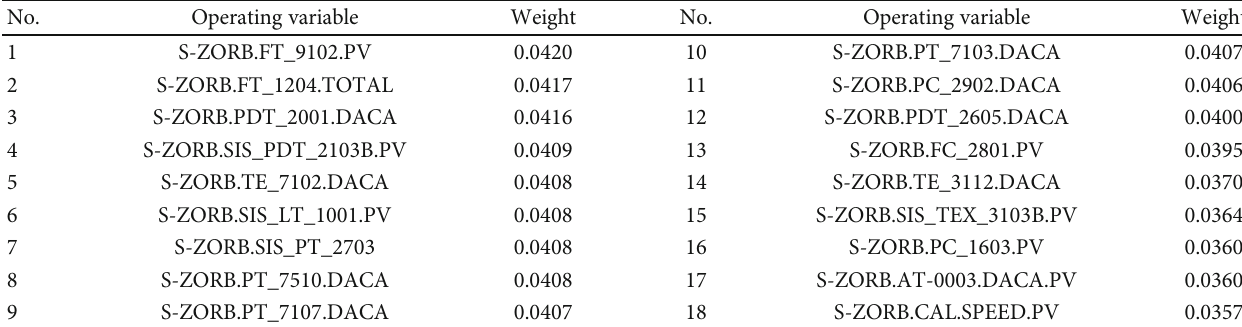
Table 2: Operating variable weight of PCA.